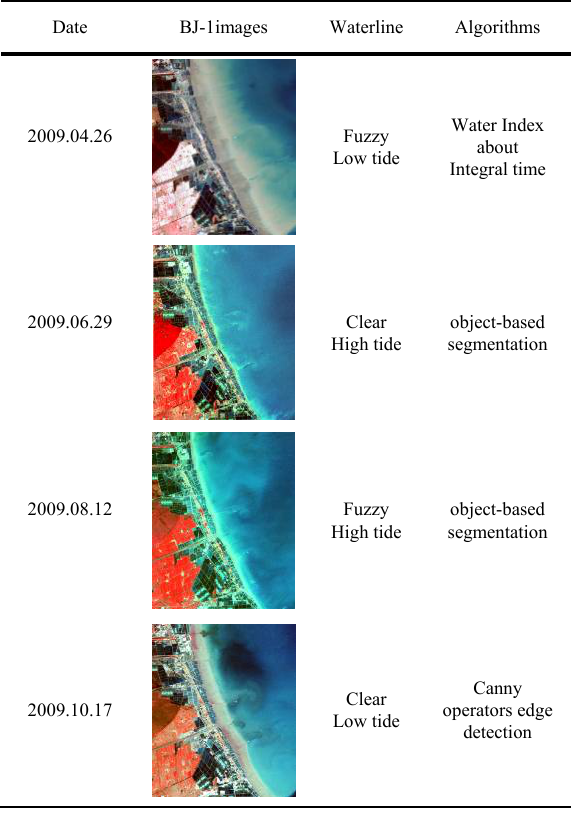
Table.1 Analysis of BJ-1 images and Waterline detection method